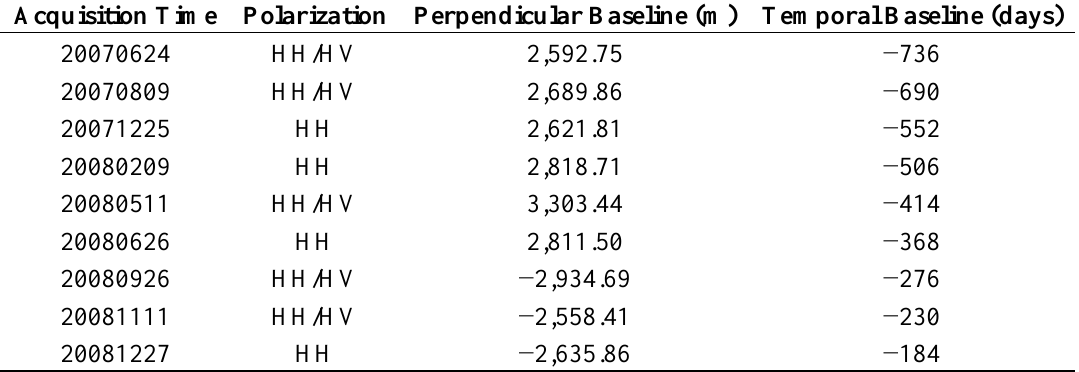
Table 1. ALOS PALSAR data used in this study covering Hong Kong, China; the image acquired in 29 June 2009 was selected as the reference for the dataset